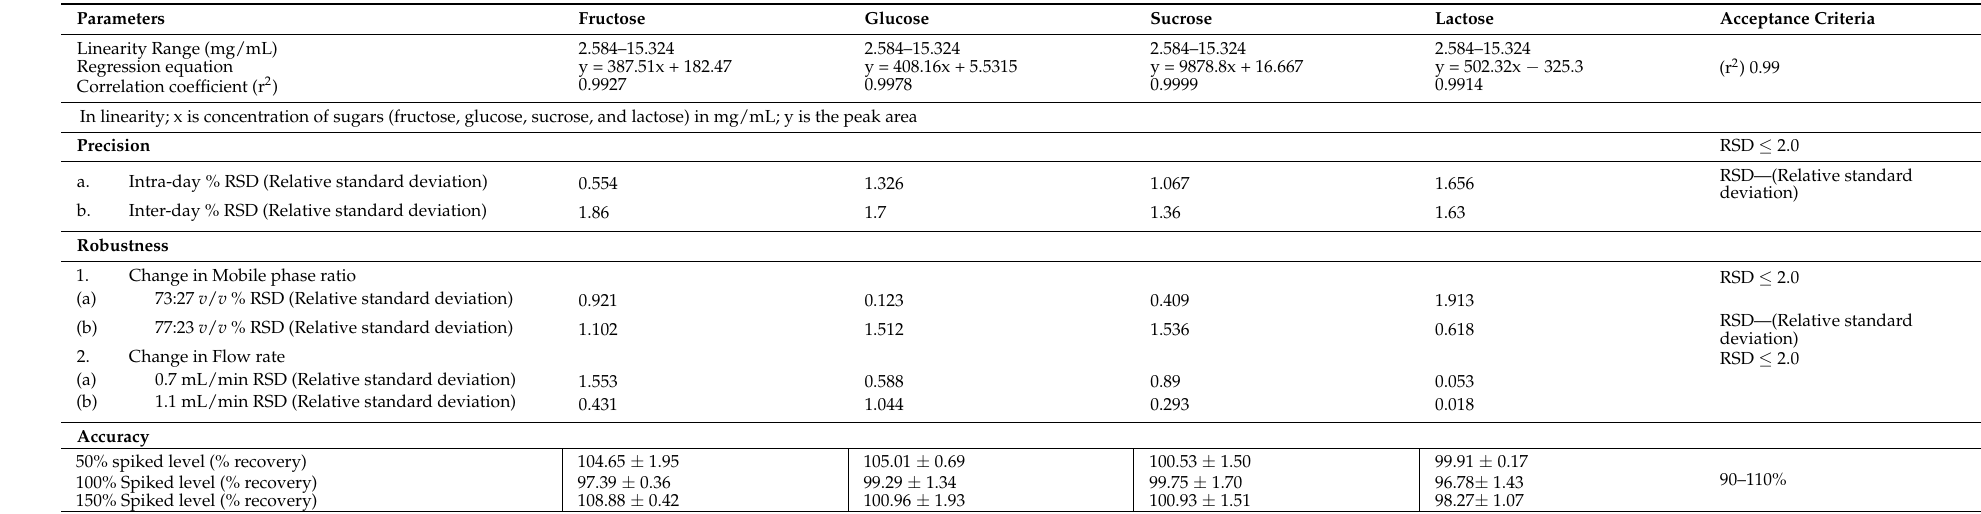
Table 4. Results of the validation parameters for sugars in eggless mayonnaise